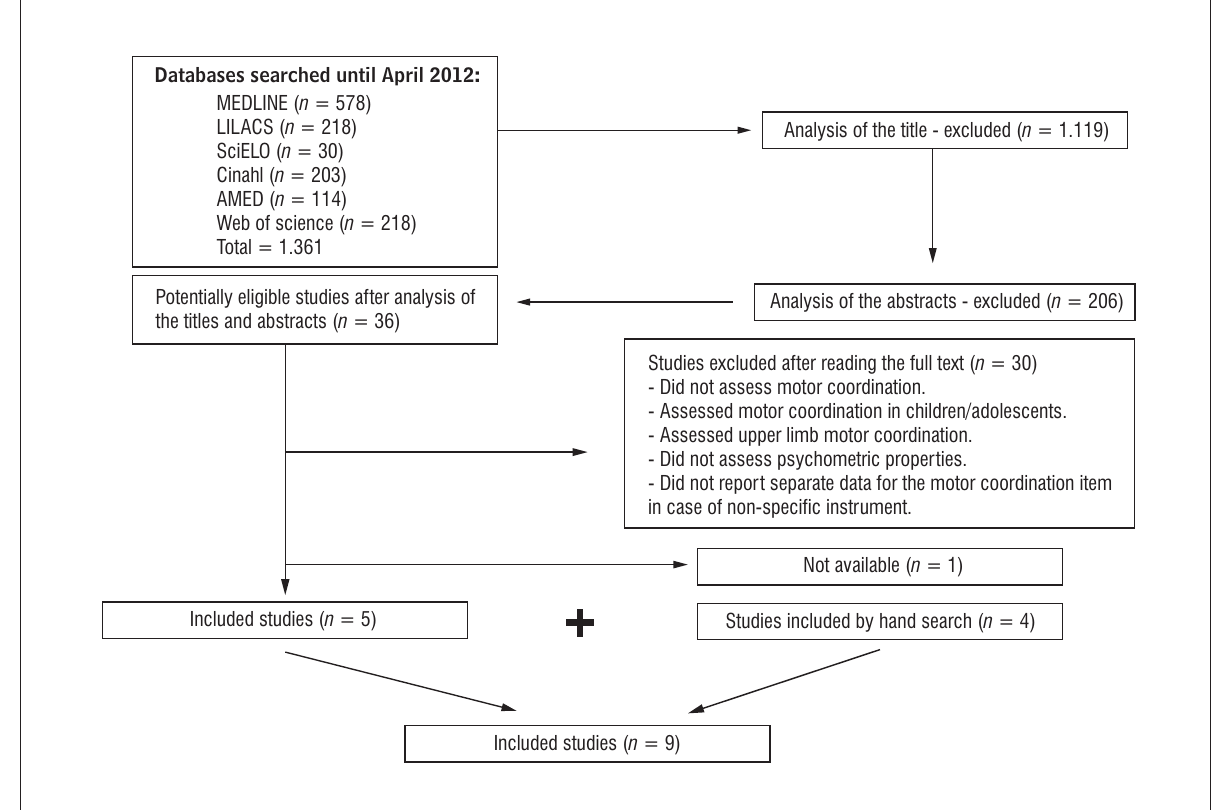
Figure 1 - Flowchart of inclusion and exclusion of